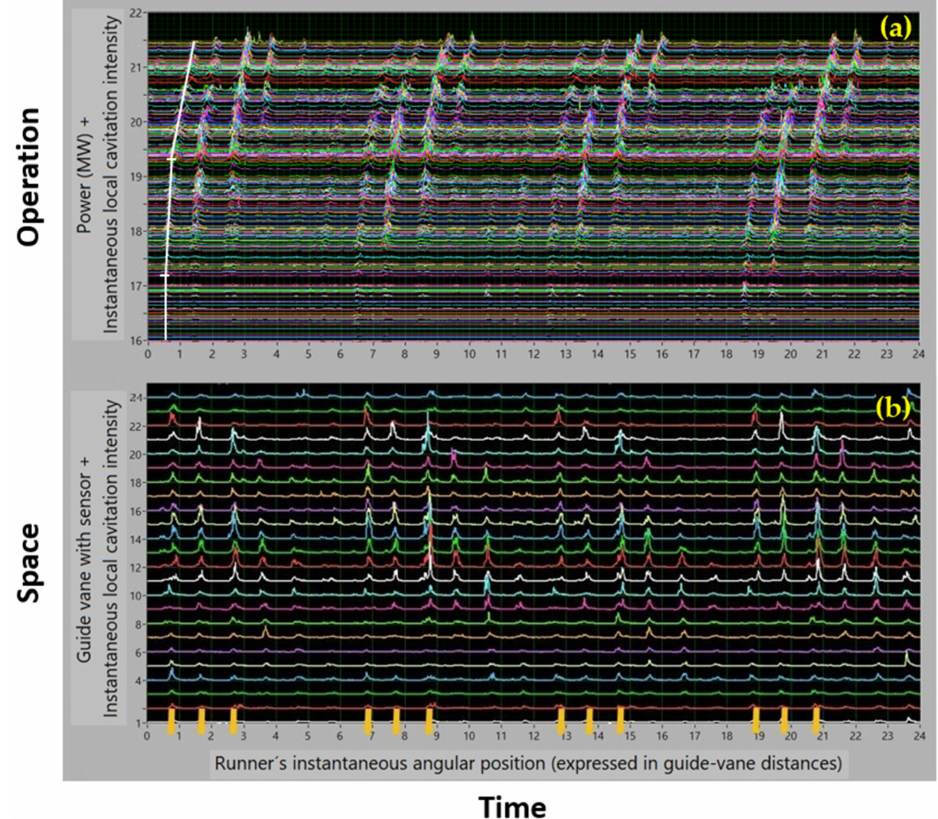
Figure 12. Two typical formats of the instantaneous cavitation intensity presentation (turbine in